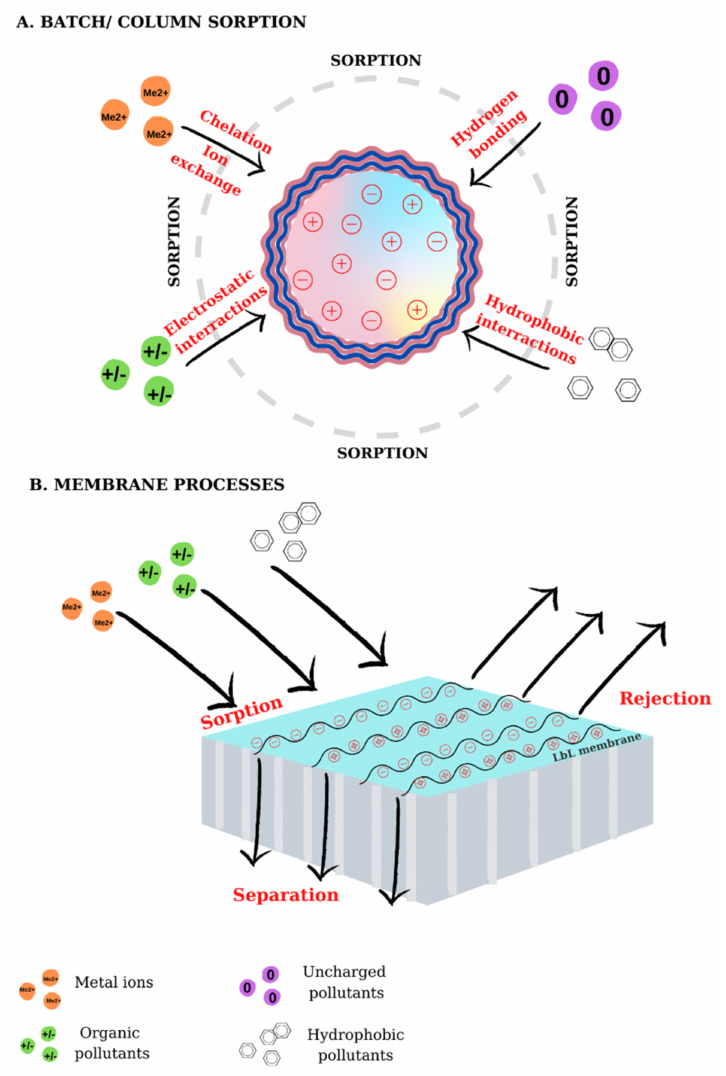
Figure 8. The sorption/rejection of pollutants by LbL-modified colloids ( A ) and membranes ( B ). Rajesh et al. [201] developed a PEs based membrane obtained by LbL deposition of branched PEI and PAA on a polyacrylonitrile (PAN) nanofibrous material. The ob- tained membrane showed a high-water flux and 98.7% retention of MgSO 4 . Similarly, de Grooth et al. [103] fabricated a PDADMAC/PSS NF membrane. Their results demon- strated a very high retention capacity for ionic species: 79% retention of CaCl 2 , 71% retention of NaCl, and 71% retention of Na 2 SO 4 . The separation performance of PEs based membranes is influenced by various factors such as the concentration of the PEs solutions used in the deposition, the nature of the last layer deposited, and the pH of the solution to be used for filtration [199]. Baburaj et al. [207] used PEI/PAA and CS/PAA membranes for the separation of two dyes (methylene blue and Coomassie brilliant blue) from water. The two membranes tested showed good removal efficiency for dyes, the amount of pollutant retained being dependent on the type of PE used and the number of deposited bilayers, and also on the pH of the dyes solution.